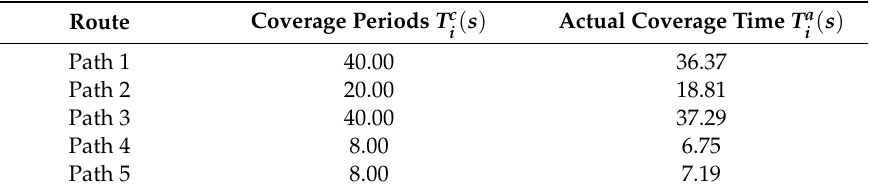
Table 5. Coverage periods and actual coverage time for each